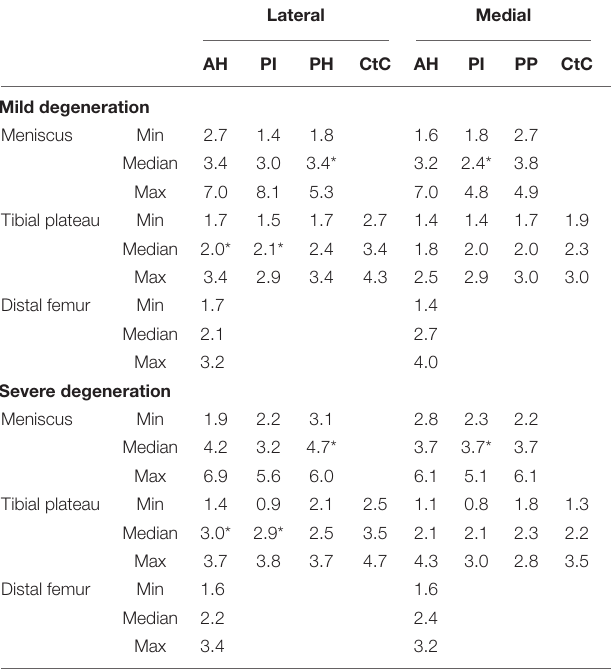
TABLE 3 | Thickness measurement results (minimum, median, and maximum values) of the cartilaginous (femur and tibia) and meniscus (AH, PI, PH, and CtC area) surface